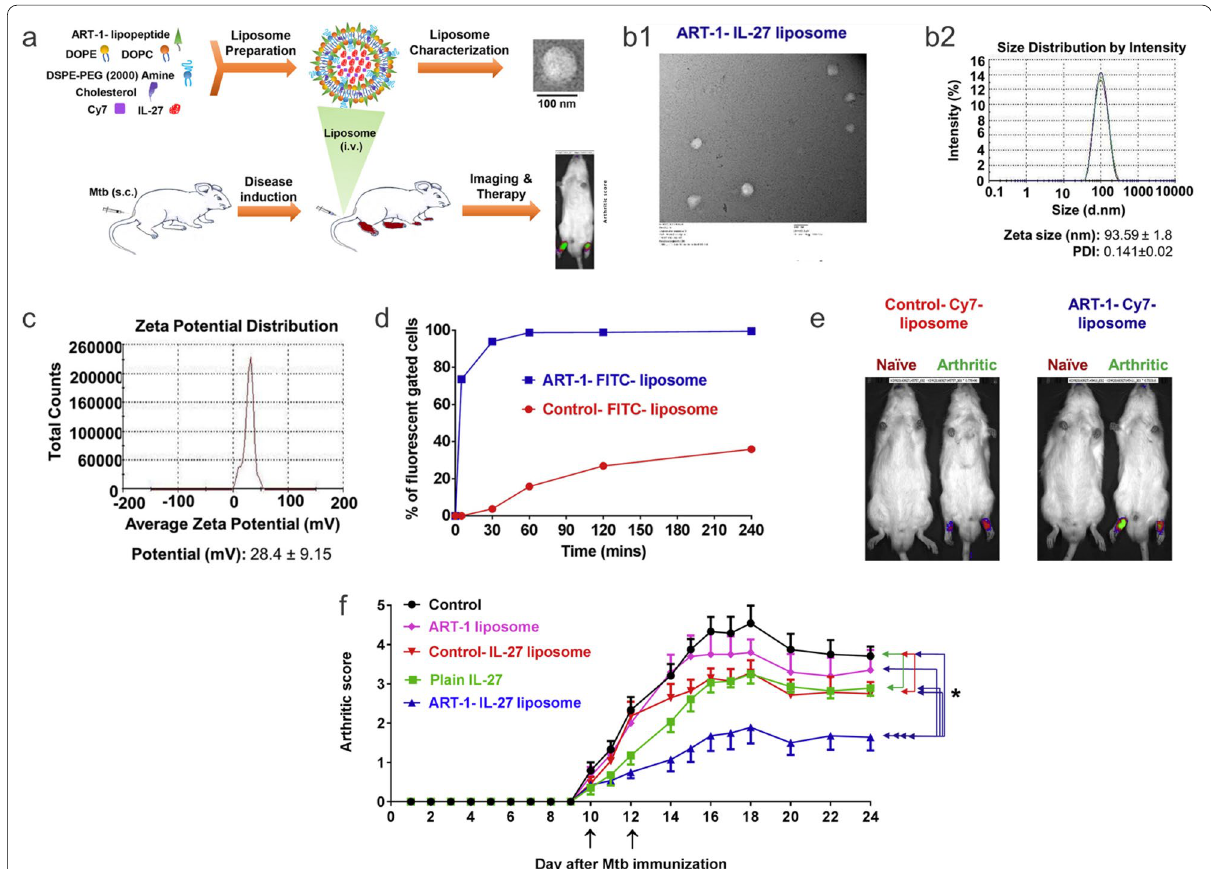
Fig. 9 Peptide targeted delivery of liposomes to modulate cytokine release in arthritis. a Schematic highlighting liposome components and in vivo delivery to arthritic rats. b Material characterization of ART‑1‑IL‑27‑liposomes. b1 and b2 illustrate the uniformity and monodispersity of the ART‑1 targeted liposome by TEM and DLS respectively. c Zeta potential measurement to highlight positive induced charge following ART‑1 incorporation. d Flow cytometry data corresponding to cellular uptake of ART‑1‑FITC‑liposomes and Control‑FITC‑liposomes at 250 nM concentrations at various time points. Liposomes modified with ART‑1 are capable of targeting and have better uptake efficiency than the control liposomes in vitro. e Real‑time fluorescent imaging of naïve and arthritic rats 4 h post I.V. injection. There is increased accumulation in the arthritic joints of the rats with the ART‑1 targeting ligand relative to the control. Naïve rats do not demonstrate particle accumulation. f Arthritic score of groups of rats treated with combinations of the ART‑1‑IL‑27 liposome. The group that received with ART‑1‑IL‑27‑lipsosme demonstrate better recovery with a lower arthritic score than the control and groups treated with either ART‑1 liposome, Control‑IL‑27 liposome, or Plain IL‑27. Reproduced with